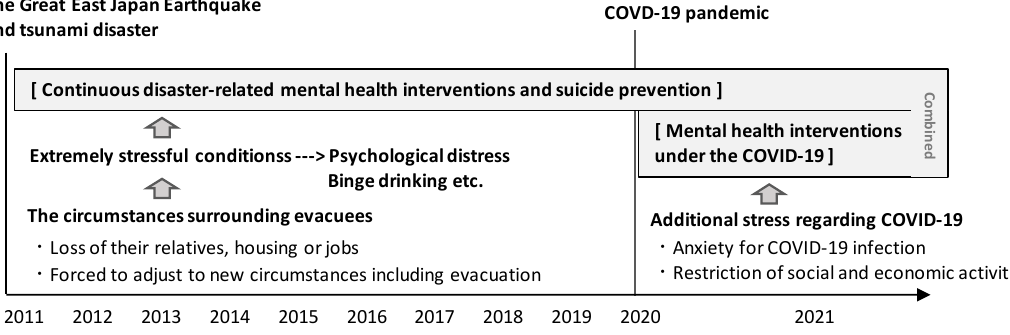
Figure 1. The conceptual model of disaster-related mental health interventions.